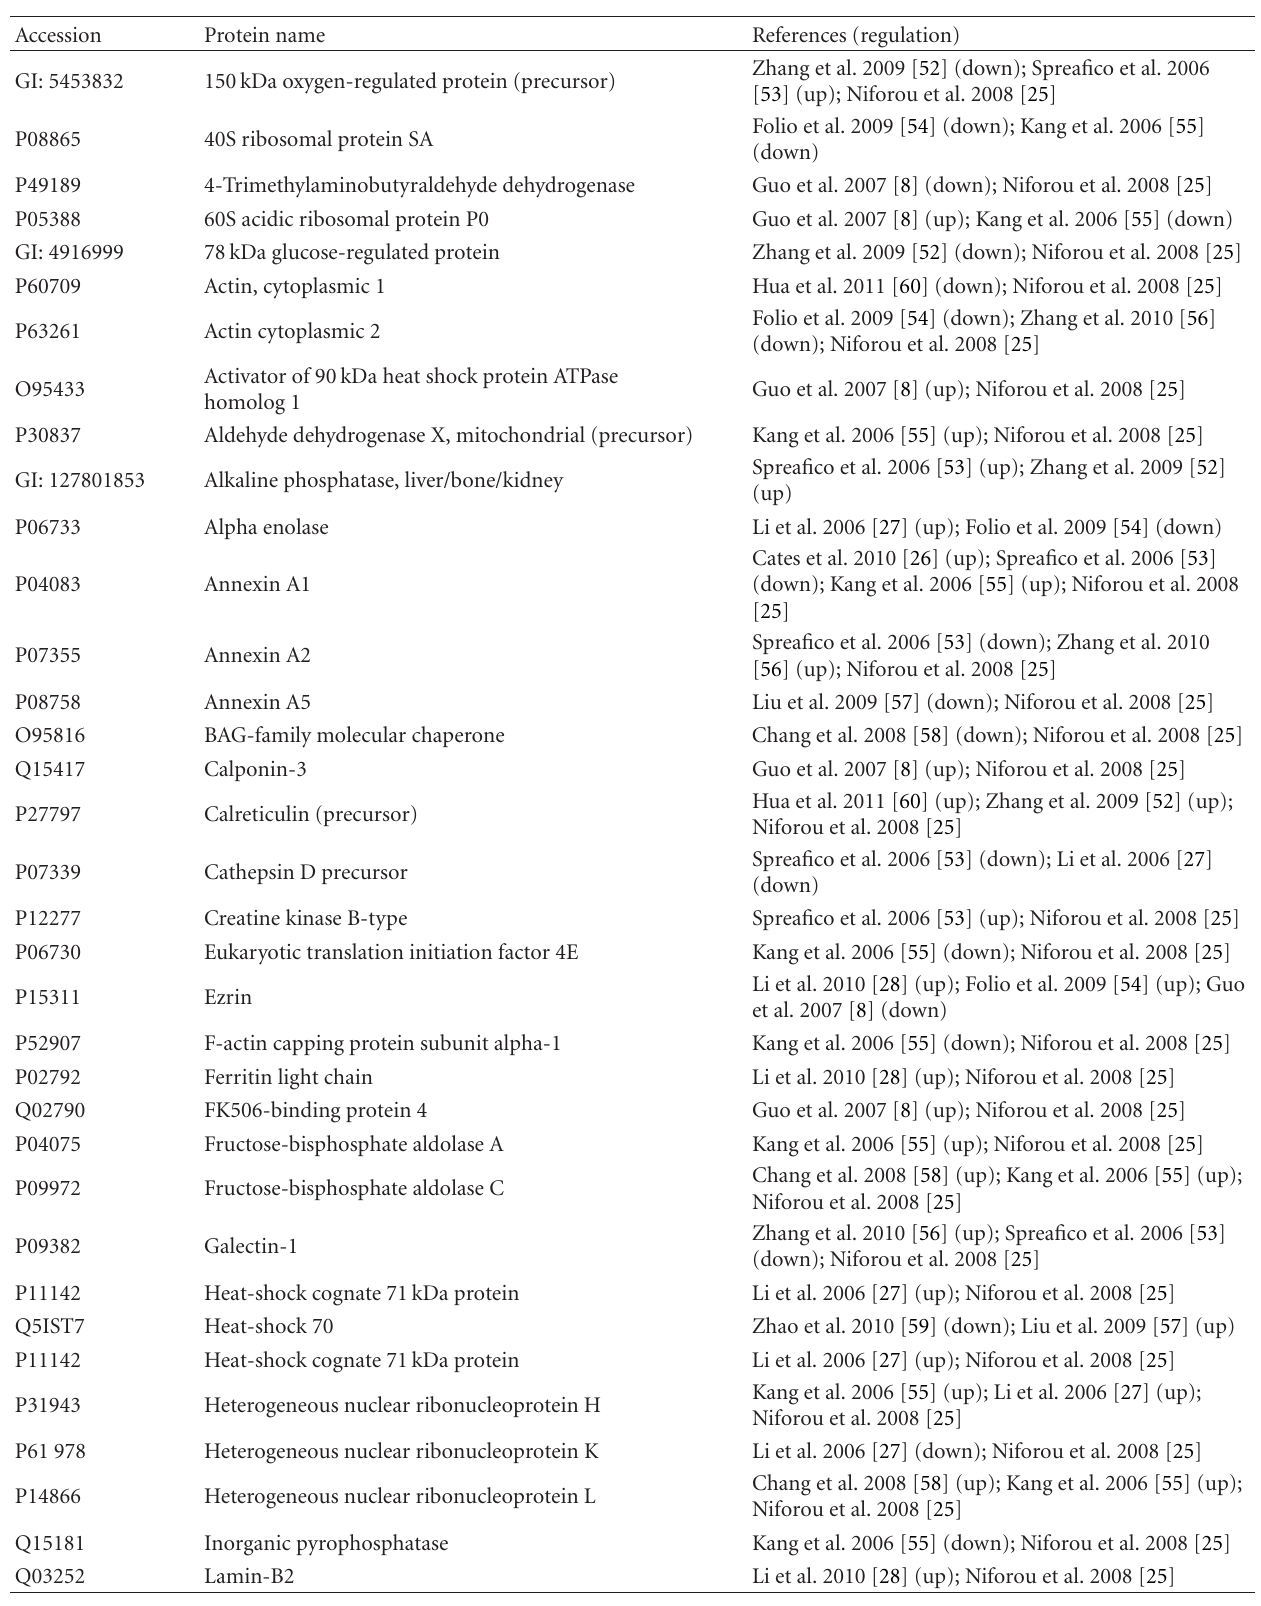
Table 1: Commonly identified proteins from multiple proteomic studies. The first column represents the accession number of the protein, followed by the protein name. The last column contains the author’s last name and year of the publication the protein was found to be significantly di ff erentiated with the expression level indicated in